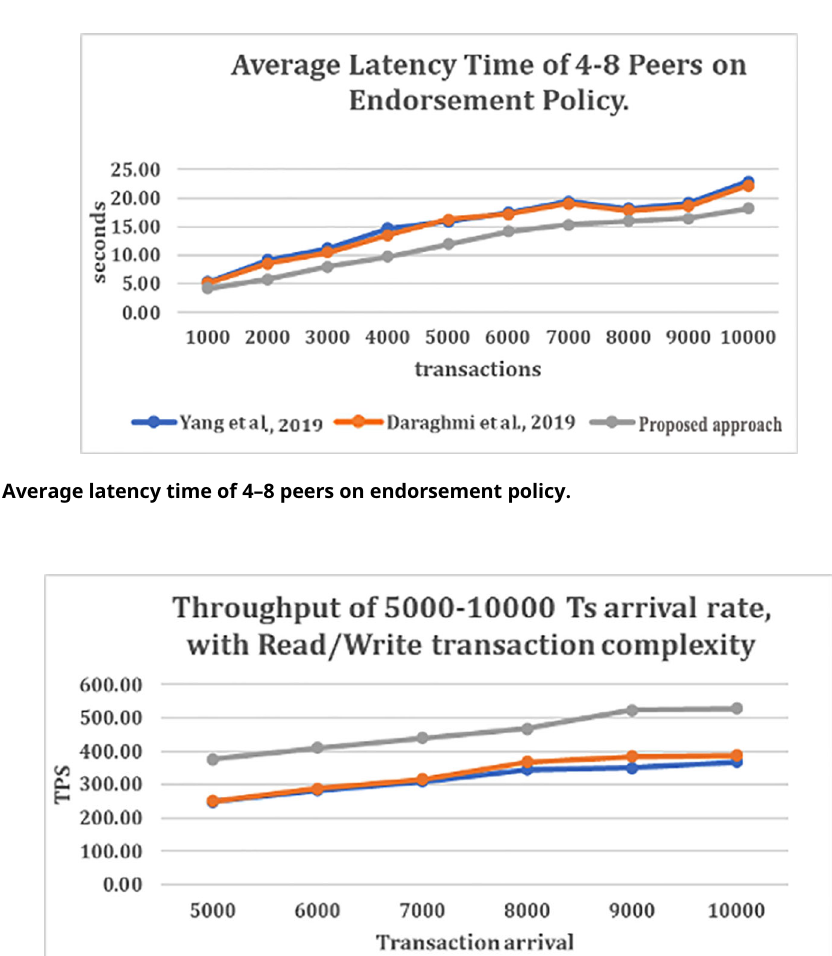
Figure 2. Average latency with block size of 200 – 400 on various transaction arrival rates.